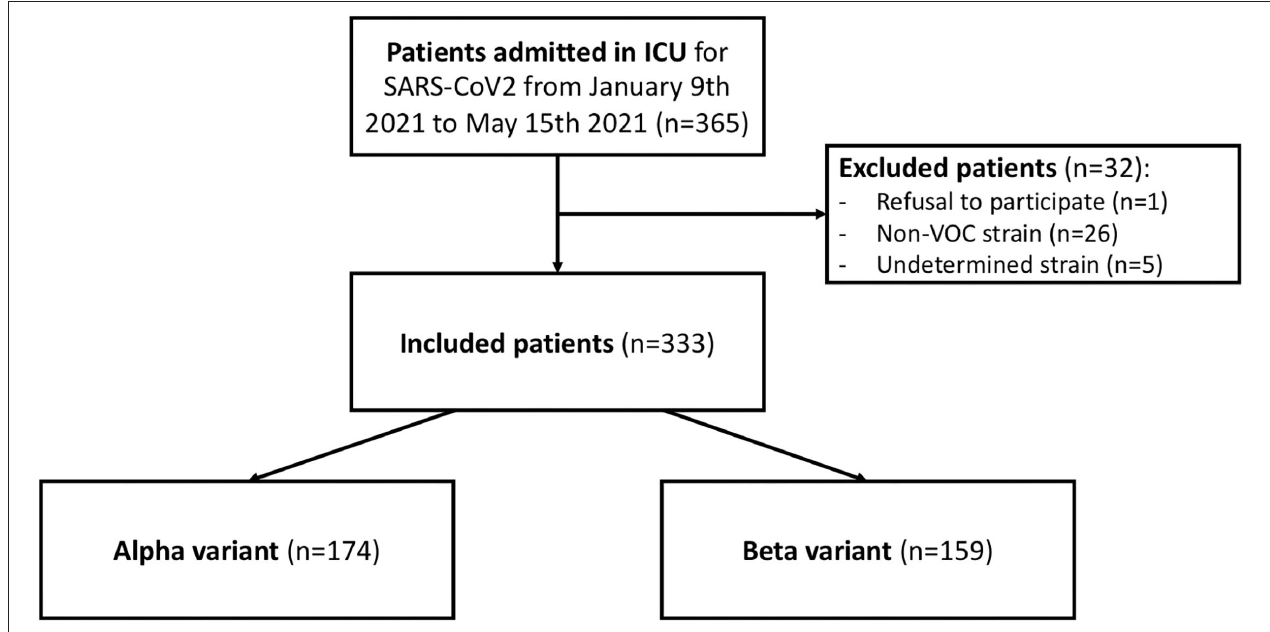
FIGURE 1 | Disposition of the patients in the